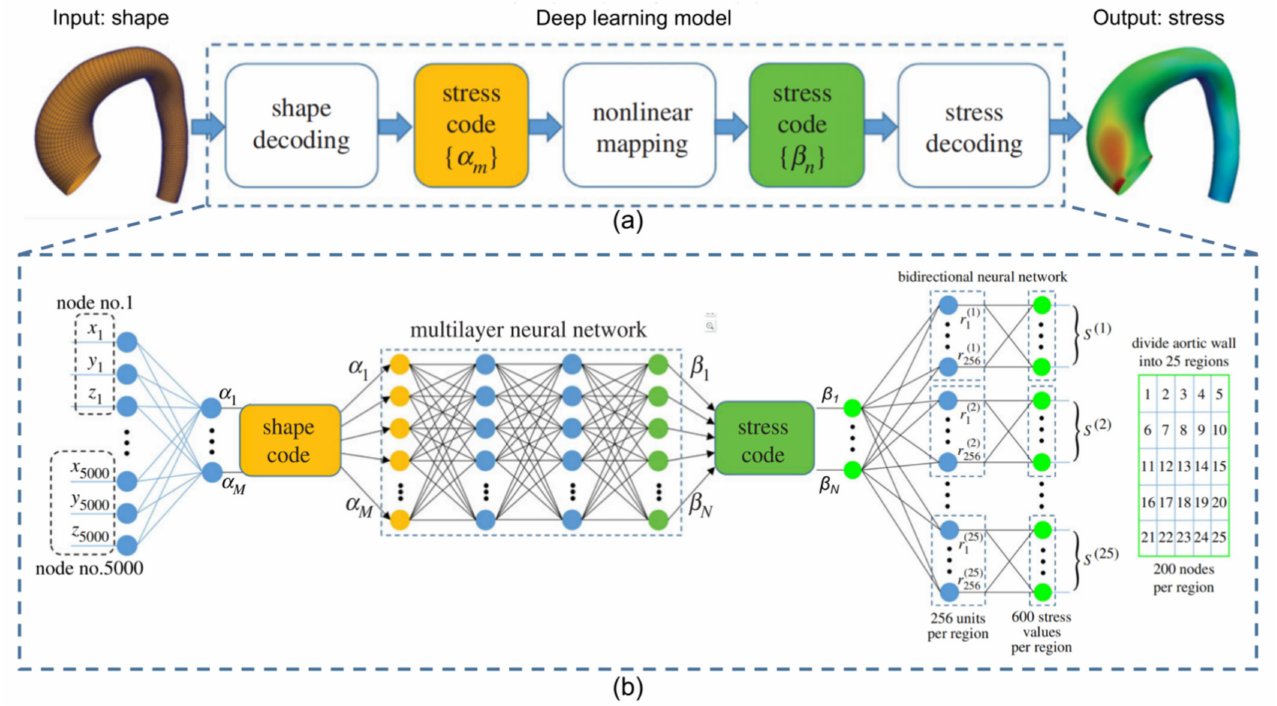
Figure 4. Case study using the deep learning (DL) technique as a surrogate of finite − element analysis for stress analysis. ( a ) The overall structure of the DL model, in which the input is an aorta shape and the output is the stress distribution of the artery wall. ( b ) The neural network for the shape encoding, mapping the shape code to the stress code, and the stress decoding and encoding. Panel ( a , b ) are adapted with permission from Reference [77], Journal of the Royal Society